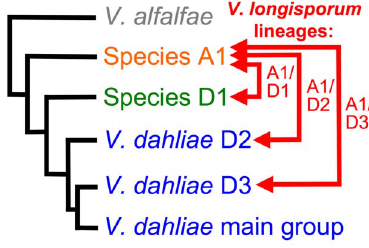
Figure 1. Evolutionary history of Verticillium longisporum illustrated by a cartoon phylogenetic tree based on Inderbitzin et al [ 47 ] . Verticillium longisporum evolved at least three different times by hybridization of Species A1with Species D1, V. dahliae lineage D2 and V. dahliae lineage D3, resulting in V. longisporum lineages A1/D1, A1/D2 and A1/D3, respectively. Verticillium dahliae isolates are in blue, Species D1 in green, Species A1 in orange and V. alfalfae in gray. Red arrows indicate parents of V. longisporum, connecting lines represent the three V. longisporum lineages. The Verticillium dahliae lineage D2 is marked as ‘V. dahliae D2’ and comprises both V. dahliae isolates and D2- alleles of V. longisporum lineage A1/D2. The Verticillium dahliae lineage D3 (‘ V. dahliae D3’) comprises only D3-alleles of V. longisporum lineage A1/D3. Most of the V. dahliae isolates in Inderbitzin et al. [47] belonged to the clade marked ‘ V. dahliae main group’. Tree is not to scale.